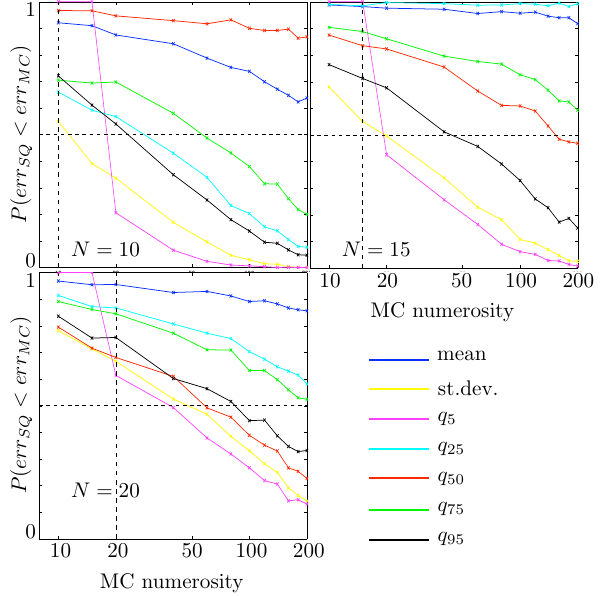
Fig. 8. Comparison between the SQ and MC simulations, analogous to Fig. 5.